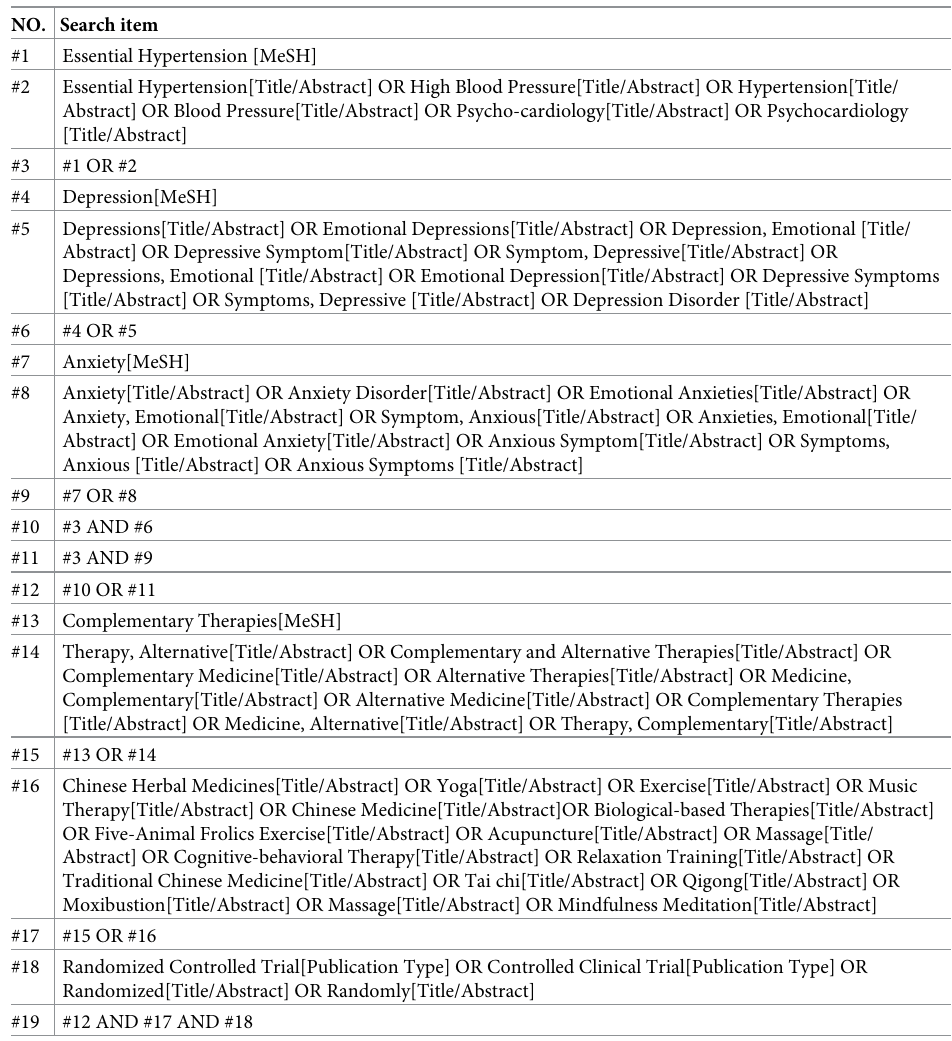
Table 1. Search strategy for